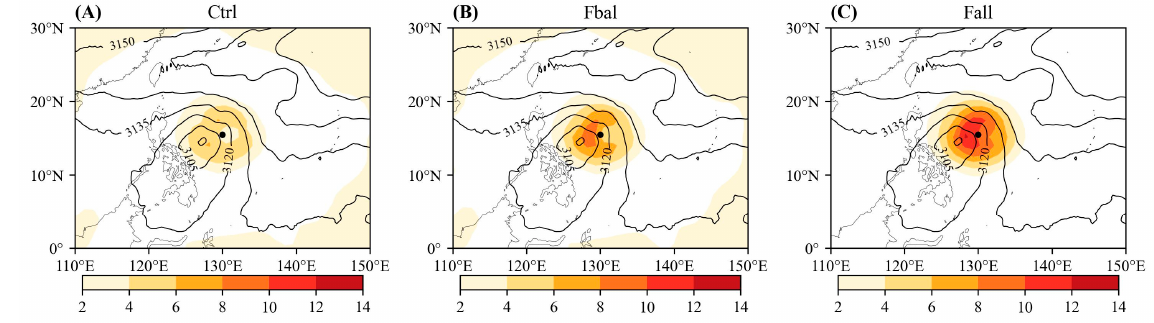
Figure 4. Single observation analysis increments for temperature at model level 105 (~700 hPa) valid on 19 October 2020, 0900 UTC. ( A – C ) correspond to the “ctrl”, “fbal” and “fall” experiments, respectively. Unit: 10 − 3 K. The corresponding 700 hPa geopotential height analysis is overlaid, contour: 15 gpm. The black dot shows the observation position.